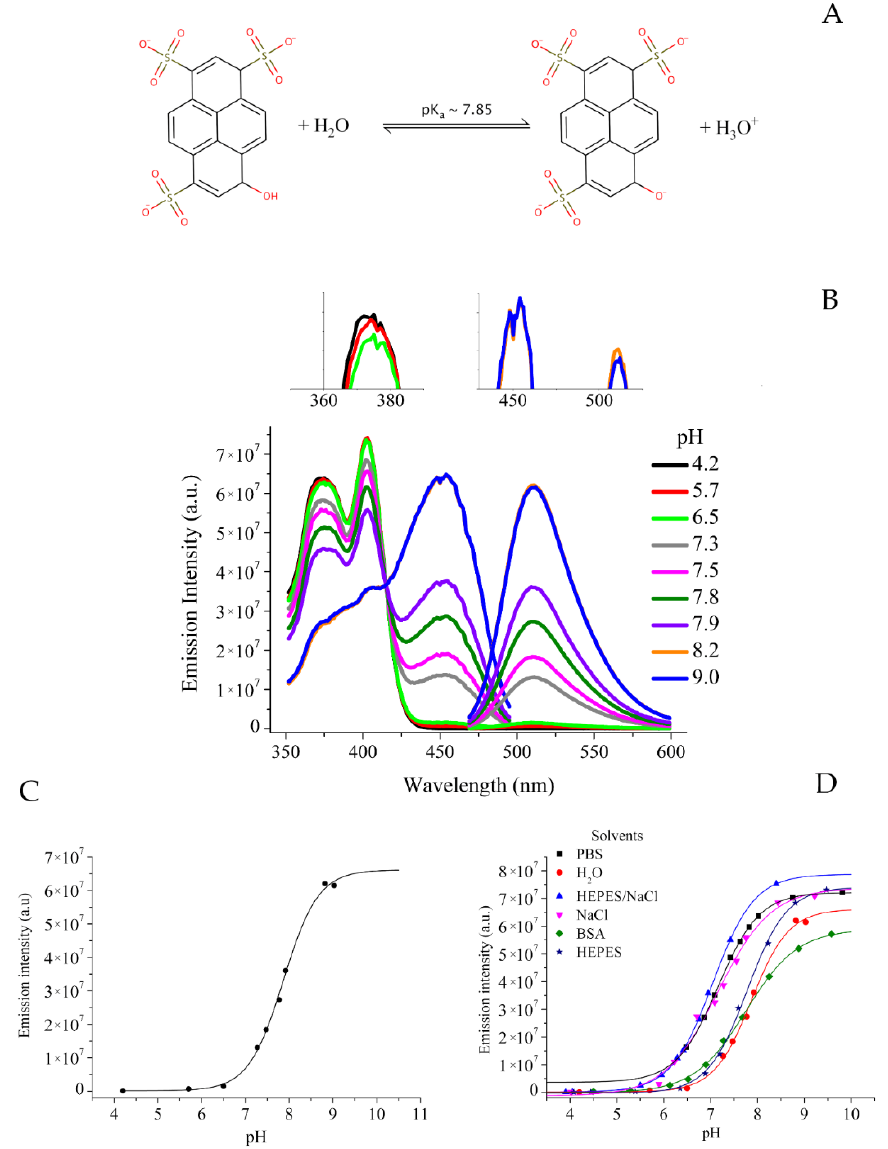
Figure 1. ( A ) Equilibrium reaction with calculated pK a value. ( B ) Excitation and emission spectra in water at variable pH values. ( C ) Sigmoidal behavior of the emission intensity at variable pH in water. ( D ) Sigmoidal behavior of the emission intensity at variable pH in different media.